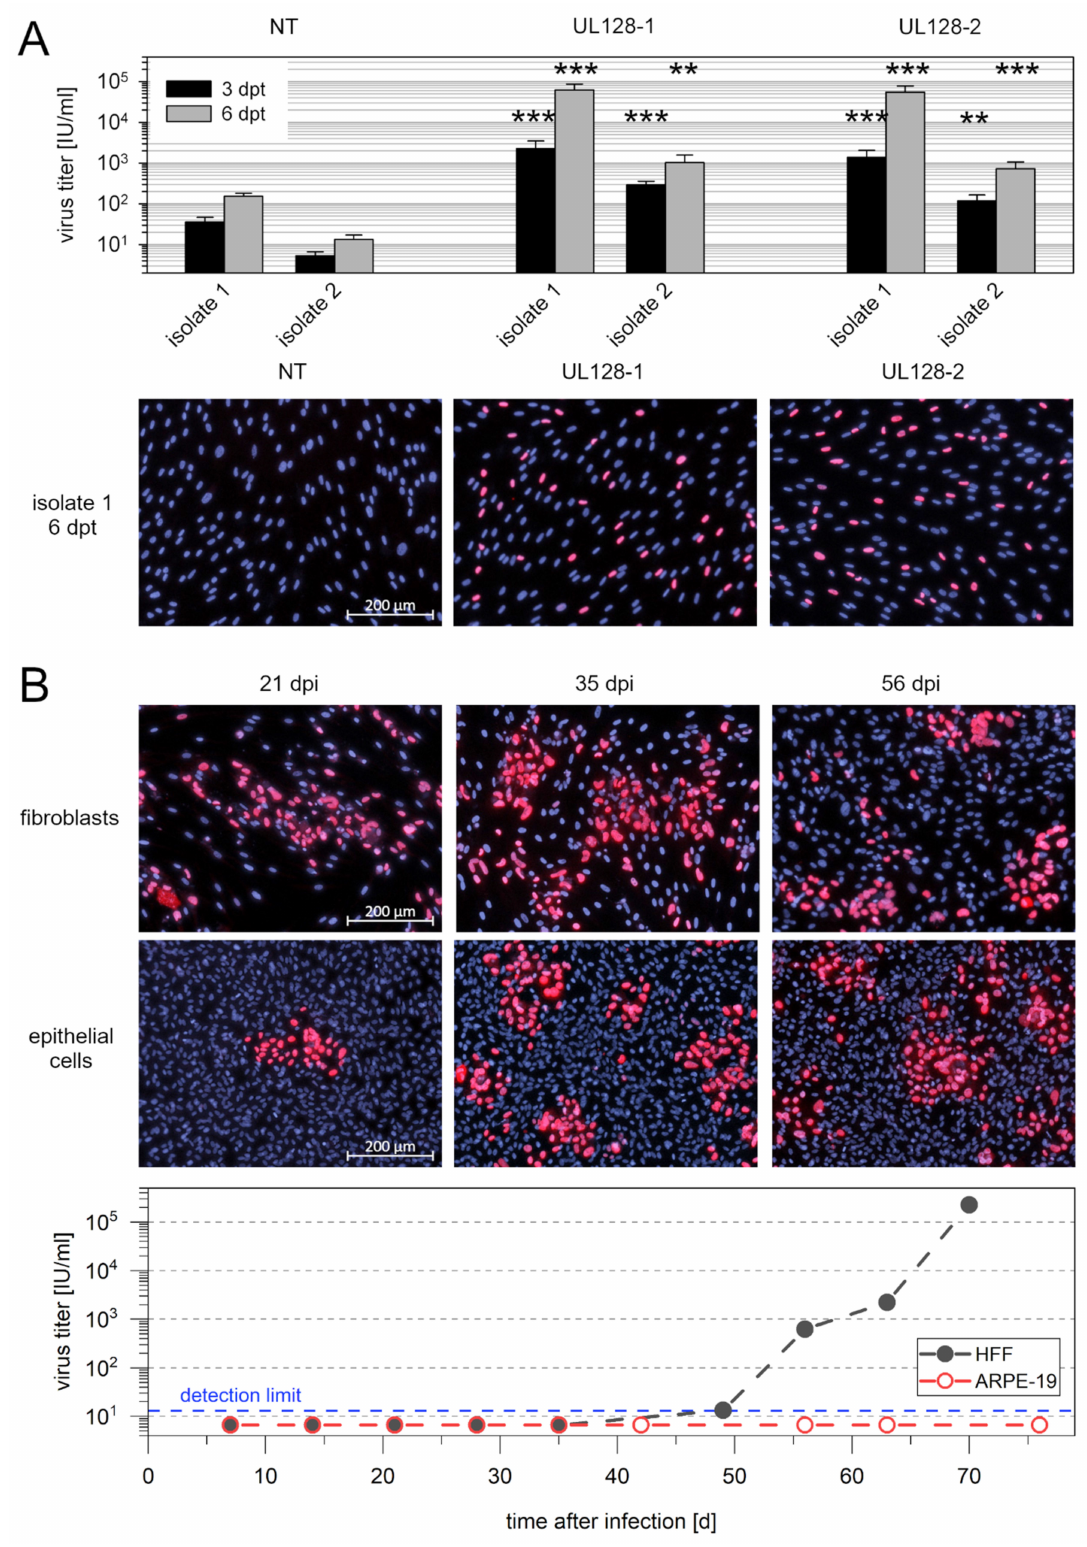
Figure 6. Effect of siRNA-mediated knockdown of pUL128 on release of cell free infectivity from recent clinical HCMV isolates. Human fibroblasts (HFFs), infected with recent HCMV isolates, were transfected with two individual siRNAs targeting transcripts of the viral gene UL128. Nontargeting siRNAs (NT) were included as a control. ( A ) Three days or six days after transfection (dpt), supernatants of the transfected cultures were harvested, clarified from cells and debris, and tested for infectivity. For this, the cell-free supernatants were incubated with uninfected HFFs overnight, fixed and